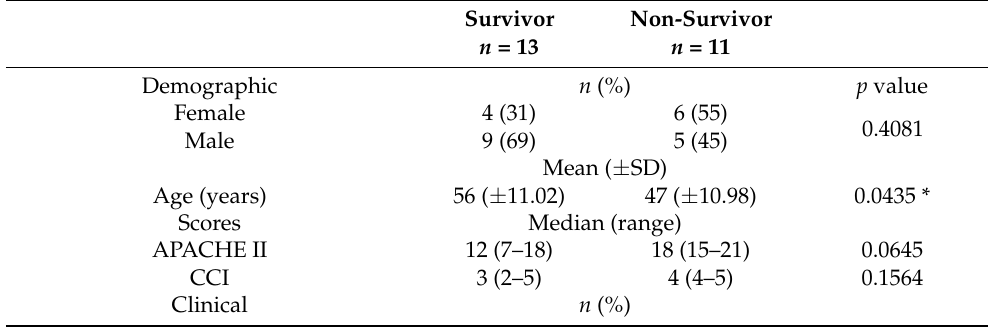
Table 1. Baseline characteristics of patients at enrollment.